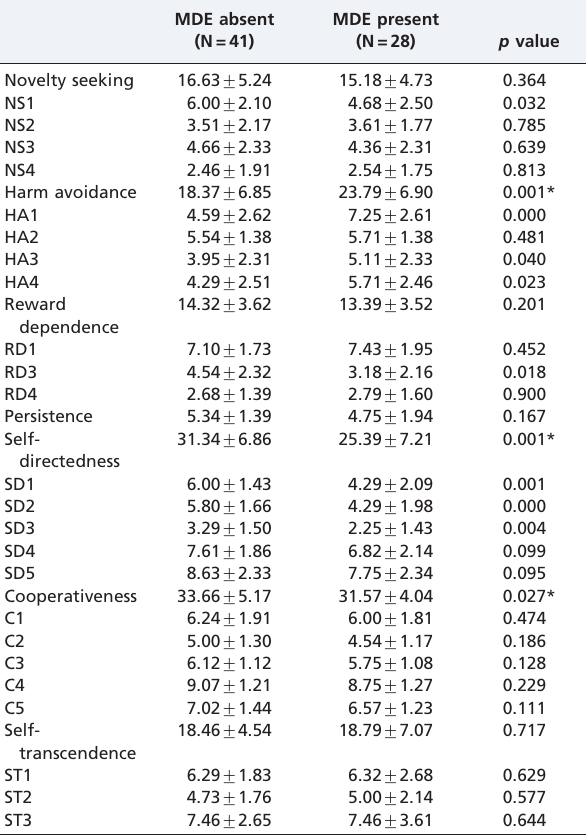
Table 2 - Comparison between temperament and character inventory dimensions of female FMS patients with and without a current major depressive